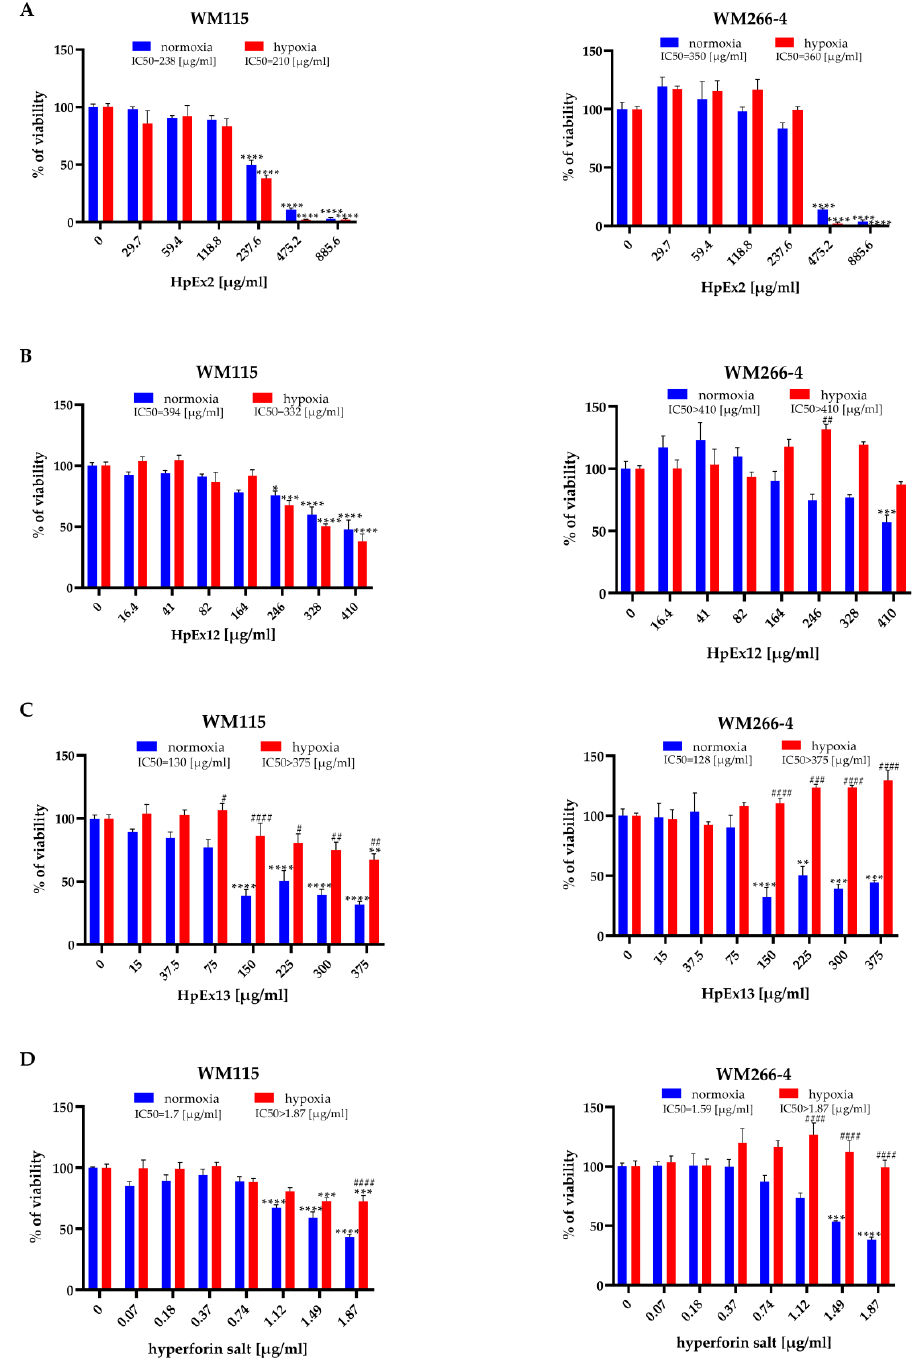
Figure 1. Effects of Hypericum perforatum extracts ( A – C ) and hyperforin salt ( D ) on the viability of the WM115 and WM266-4 human melanoma cell lines cultured under normoxia (blue bars) and